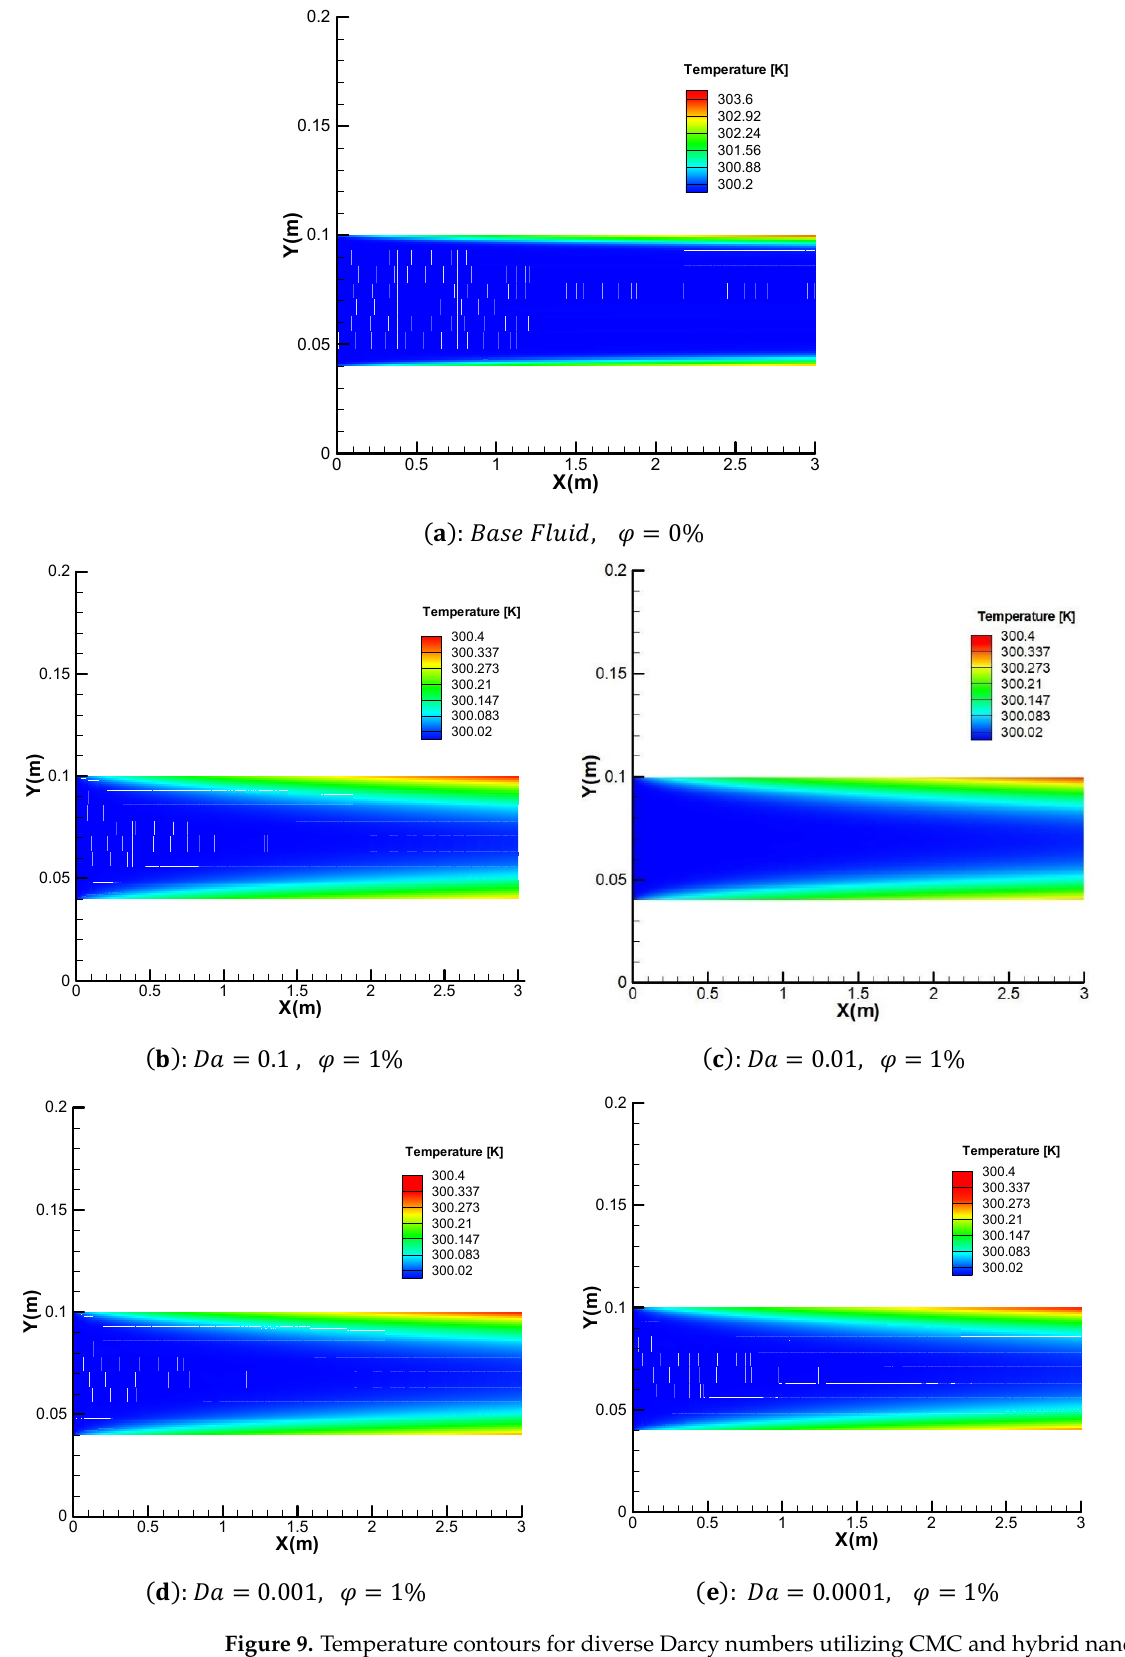
Figure 9. Temperature contours for diverse Darcy numbers utilizing CMC and hybrid nanofluid at different Darcy numbers, considering ( r p = 1 ).